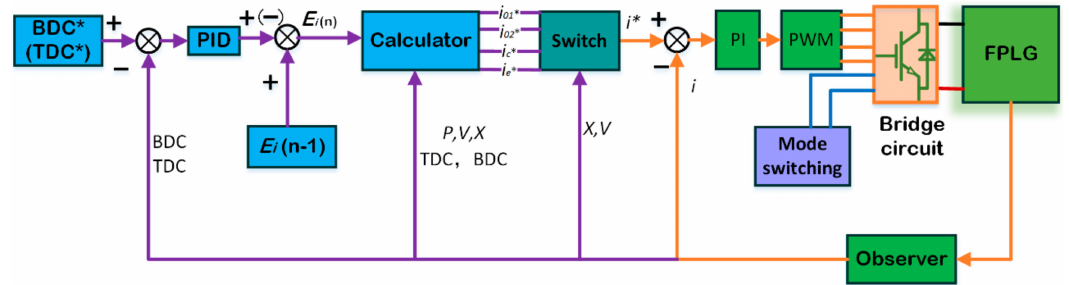
Figure 7. The force control strategy of